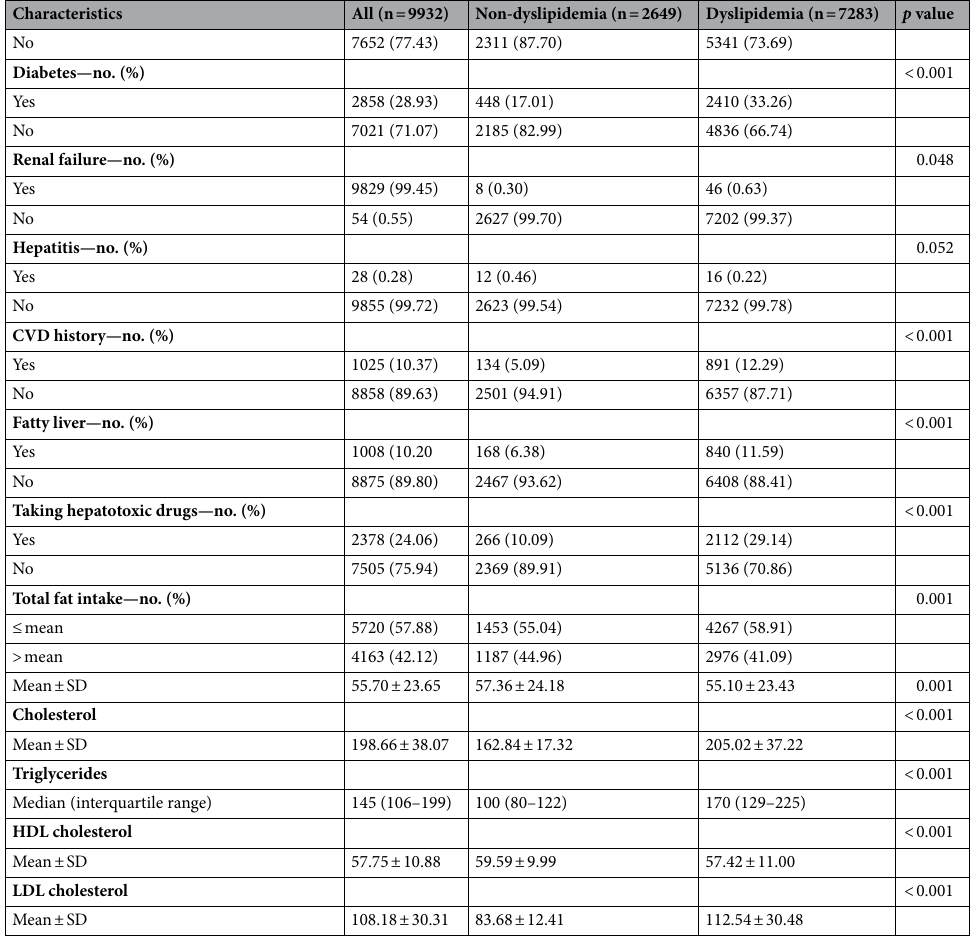
Table 1. Demographic, selected medical and laboratory characteristics of study participants (n =